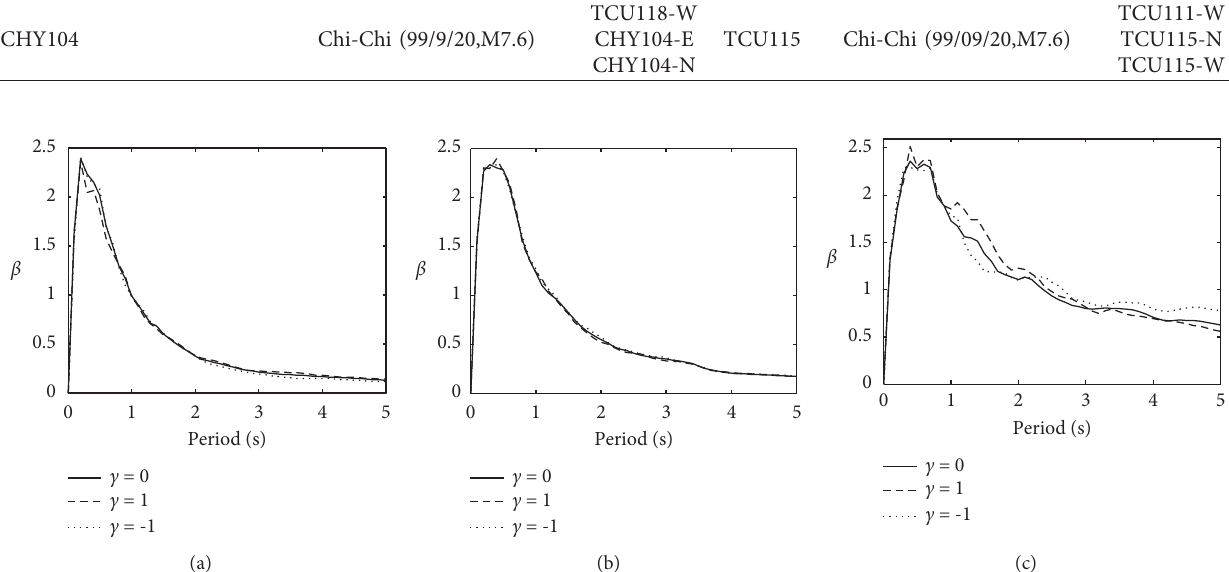
Figure 3: Amplification coefficient spectra under original one-directional earthquake “A”s ( c � 0) and superposition of bidirectional earthquake “A”s ( c � 1 and − 1) (damping ratio ξ � 0.05). (a) Hard soil site. (b) Intermediate hard (soft) soil site. (c) Soft soil